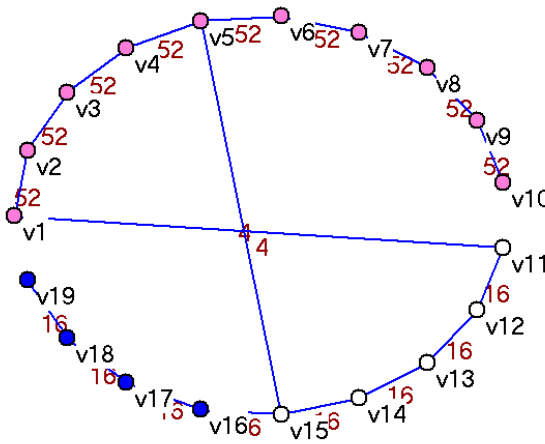
Figure 5. The k-core decomposition of the SCSG graph representing the 19 files in Table 1 using CHAIN topology.